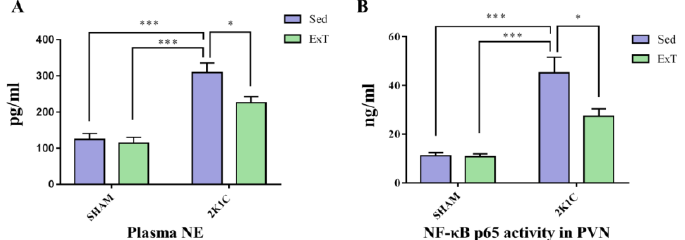
Figure 3. The effect of eight weeks of aerobic ExT treatment on the level of circulating NE and on the NF- κ B activation in the PVN in the four groups. ( A ) Statistical analysis of NE. ( B ) Statistical analysis of NF- κ B p65 activity. * p < 0.05, *** p < 0.001, n =